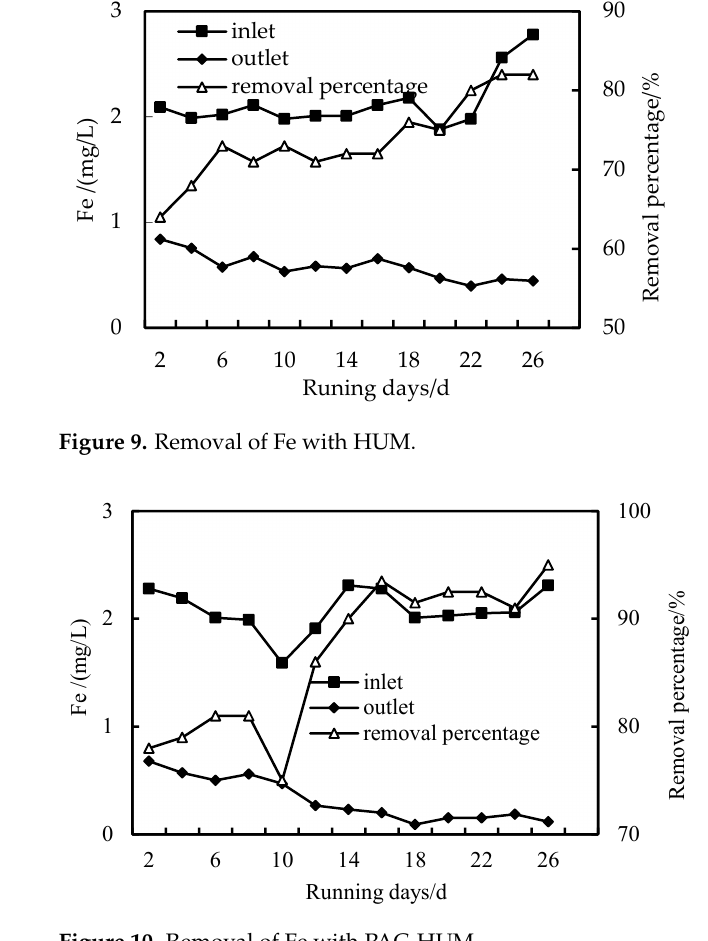
Figure 10. Removal of Fe with PAC-HUM.